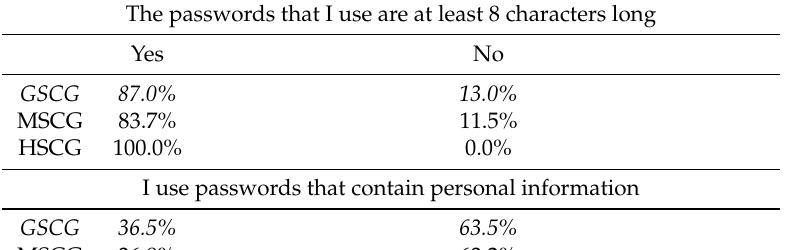
Table 12. What type of password are you most likely to